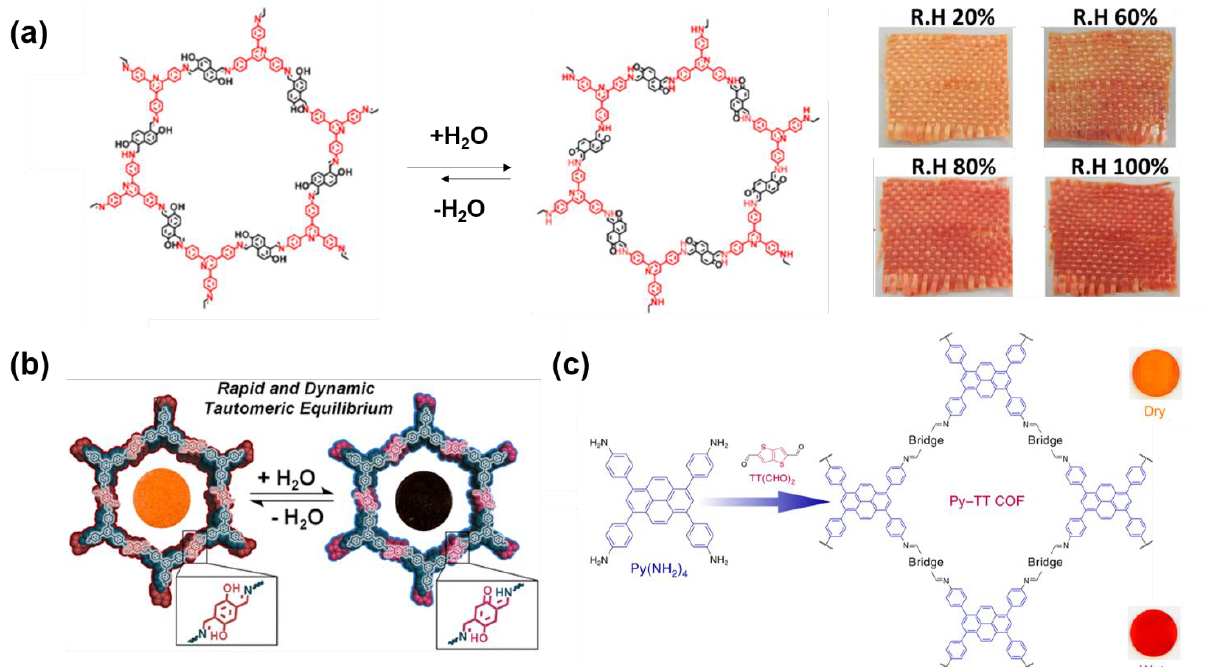
Figure 5. ( a ) TAPP − DHNDA − COF/aramid hybrid material for humidity detection [54]. Copyright 2013 American Chemical Society; ( b ) Py – TT COF thin film for humidity detection [53]. Copyright 2018 Nature Publishing Group; ( c ) Py − TT COF for humidity detection [55]. Copyright 2020 Ameri-